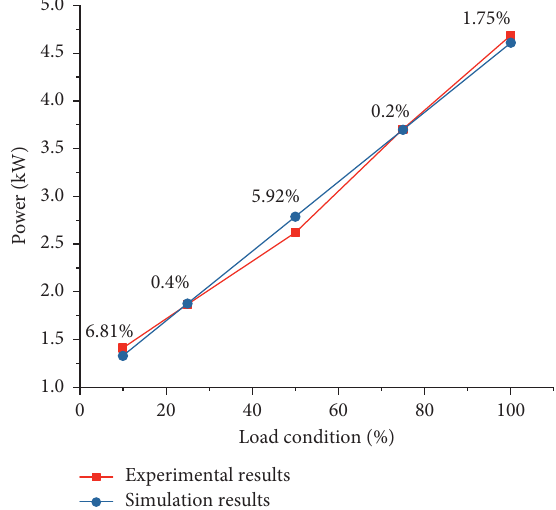
Figure 4: Simulation results comparing with the experimental results.